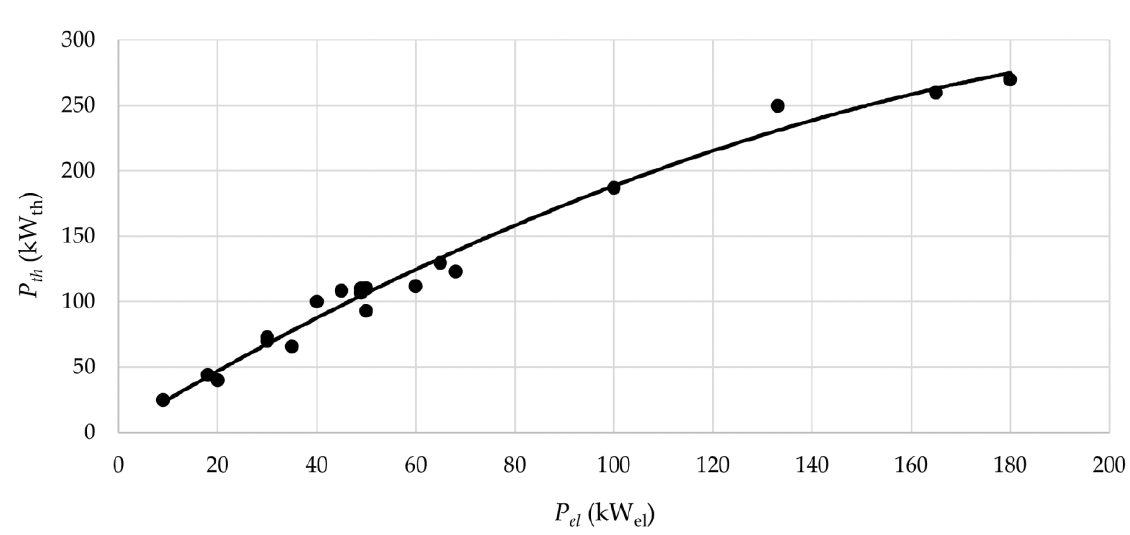
Figure 1. Dependence relation between electric and thermal output of small gasification units up to 200 kW el. The fuel consumption rates for the hypothetical variants were based on the nominal electric and thermal efficiencies supplied for the individual gasification units. A total of 21 units with an electric output from 10 to 200 kW el were assessed. The values of electric ( η el ) and thermal ( η th ) efficiency were obtained as the arithmetic mean of the reported values by manufacturers. The stated electric efficiency of these units was around 30%, while the thermal efficiency was around 55% with an overall efficiency of 85%. The resulting wood chip consumption is calculated in Table 4. Table 4. Wood chip consumption rates for chosen variants of electric power and input material moisture. P el